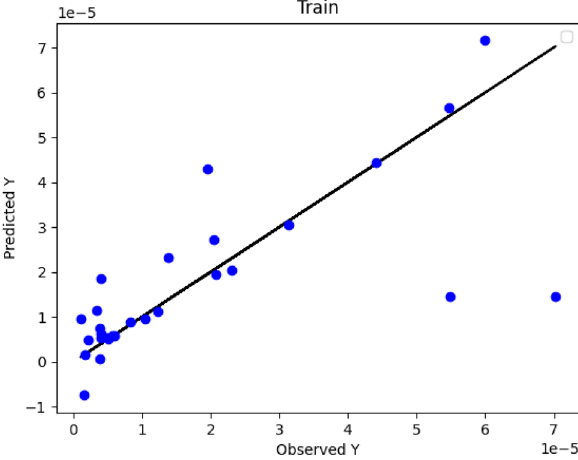
Figure 4. NU-SVR Model: actual versus predicted values/Y: solubility.